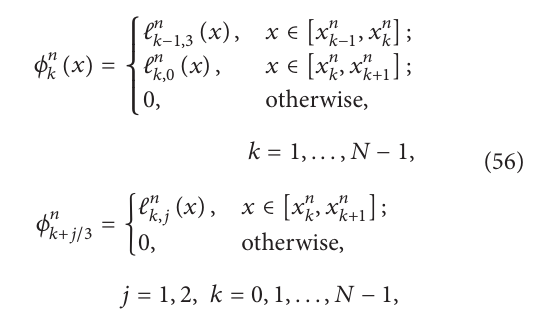
Table 1: Rate for space for 𝑔(𝑥) = 𝑥 𝜇 1 −𝑥 𝜇 2 with 𝜇 1 = 7/2 , 𝜇 2 = 7/3 for Example 6 using 1st-order FEM.